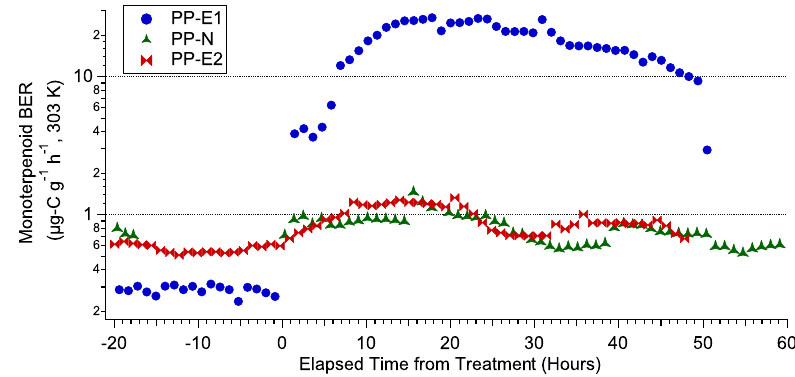
Figure 2. A summary of monoterpenoid emissions from all three Picea pungens experiment. The only experiment to exhibit a clear stress effect on monoterpenoid emission rates following treatment was the first methyl jasmonate (MeJA) experiment performed in May (PP-E1).